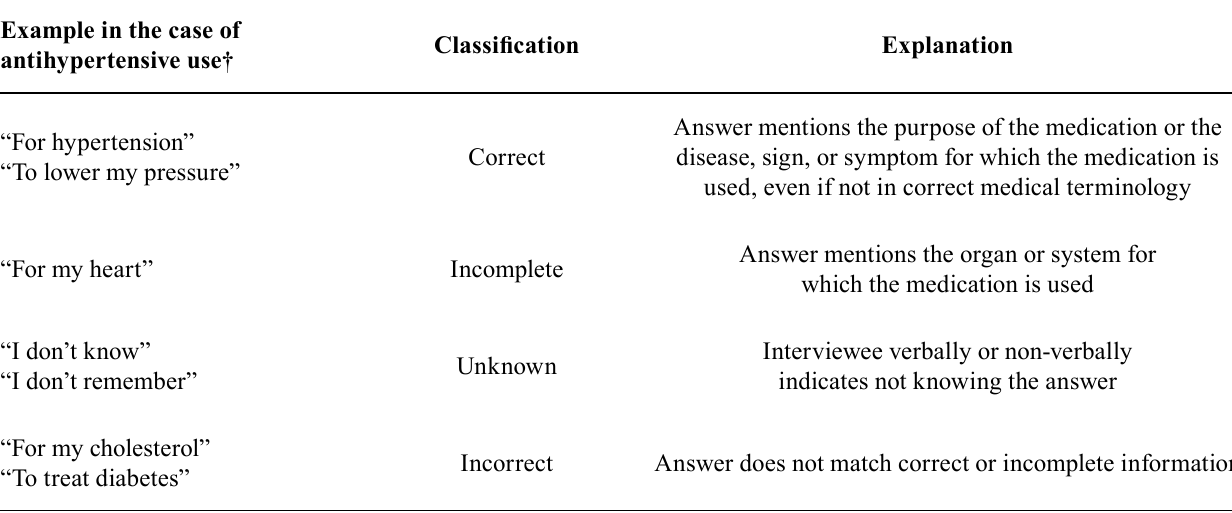
Example in the case